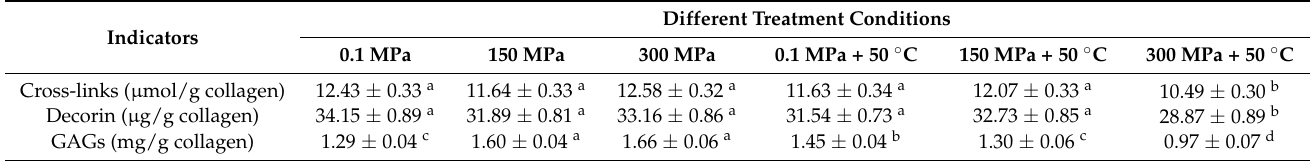
Table 2. The effect of different treatment conditions (0.1 MPa, 150 MPa, 300 MPa, 0.1 MPa + 50 ◦